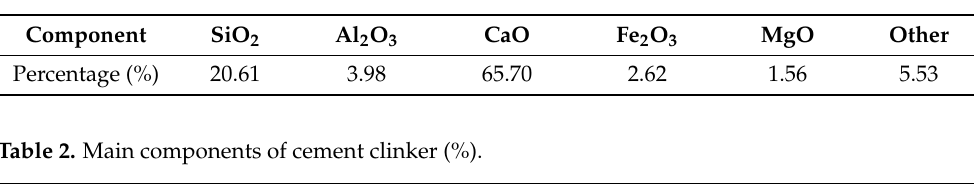
Table 1. Main chemical components of cement (%).